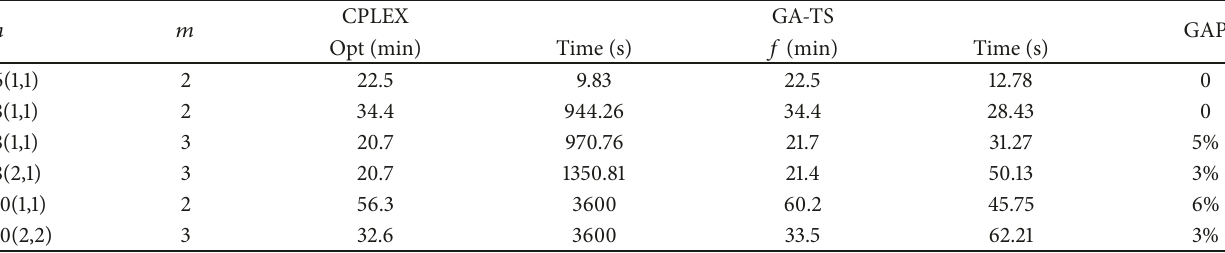
Table 4: Test results in small-sized instances.